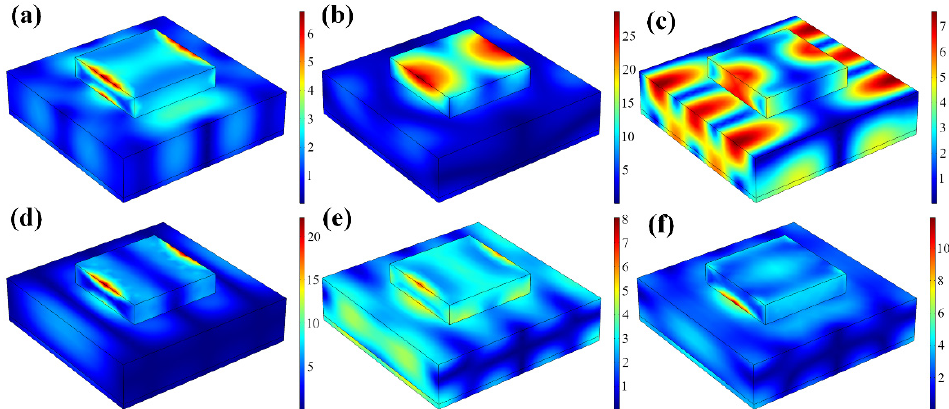
Figure 10. Variation in the electric filed distribution E (V/m) for peak resonance frequency values. Electric field distribution at ( a ) 191 THz, ( b ) 199.4 THz, ( c ) 209.8 THz, ( d ) 220.5 THz, ( e ) 233.4 THz, and ( f ) 236 THz. The refractive index of the analyte is considered 1.1 for this result.